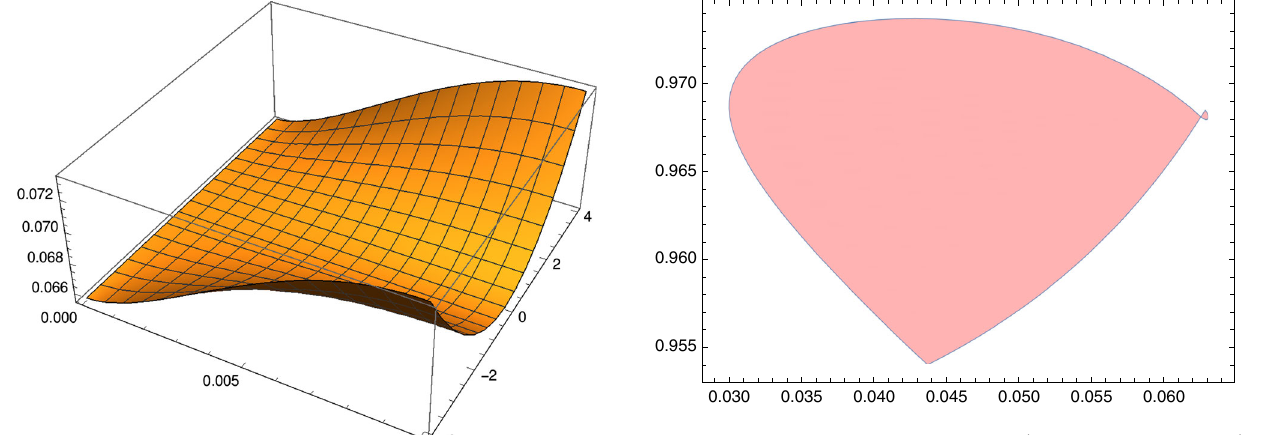
Fig. 9 Parametric plot of n s vs r for 0 (cid:2) (cid:13)/ H 0 ≤ 0 . 01, − 4 (cid:2) μ 2 /((cid:13) M ) ≤ 1 . 0 with κ H ∼ 0 . 01 and N = 60 0 found to lie within the Planck 2018 constraints, when the values of the free parameters satisfy 0 (cid:2) (cid:13)/ H 0 ≤ 0 . 01, = 0 . 01 and N = − 4 (cid:2) μ 2 /((cid:13) M ) ≤ 1 . 0 with κ H 0